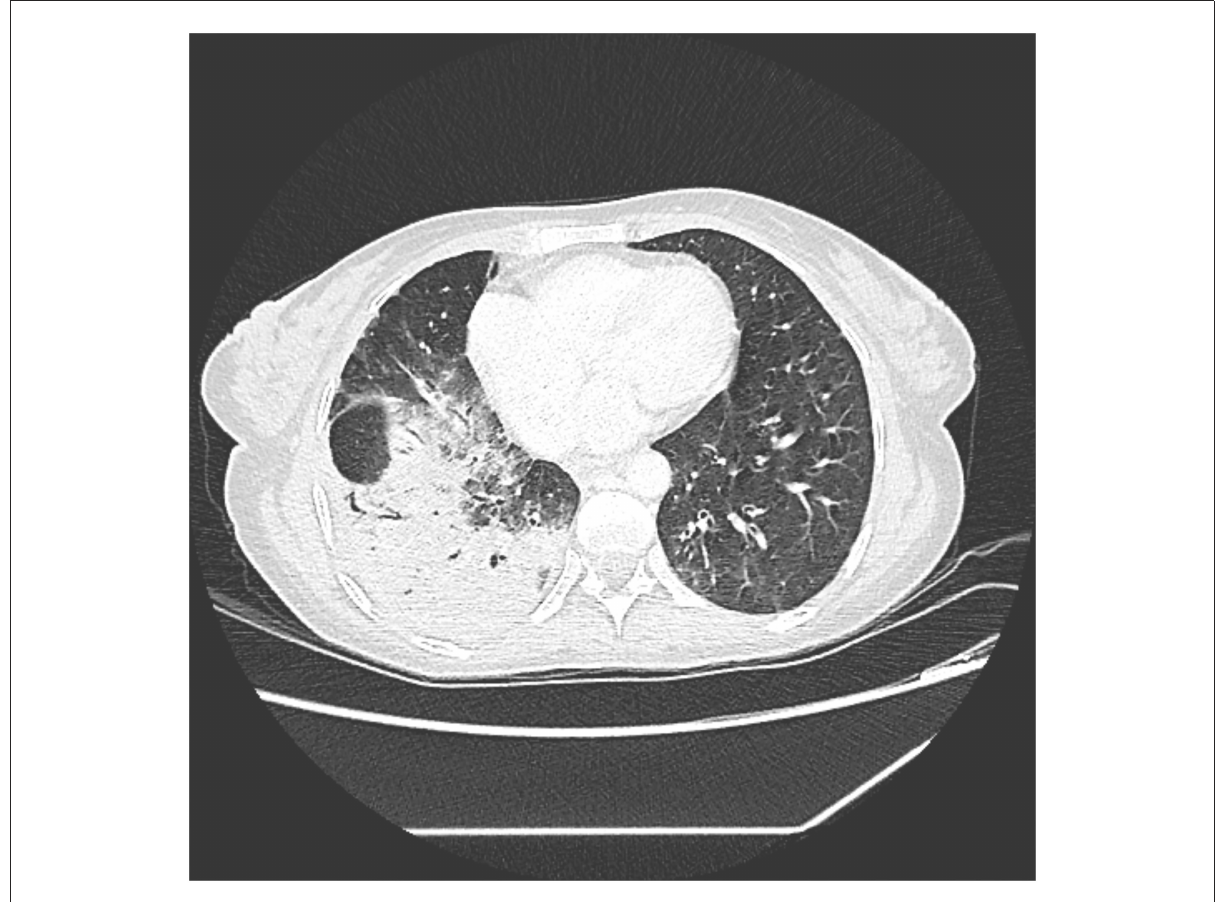
FIGURE2 Slice of CT scan showing parenchymal consolidation of the right lower